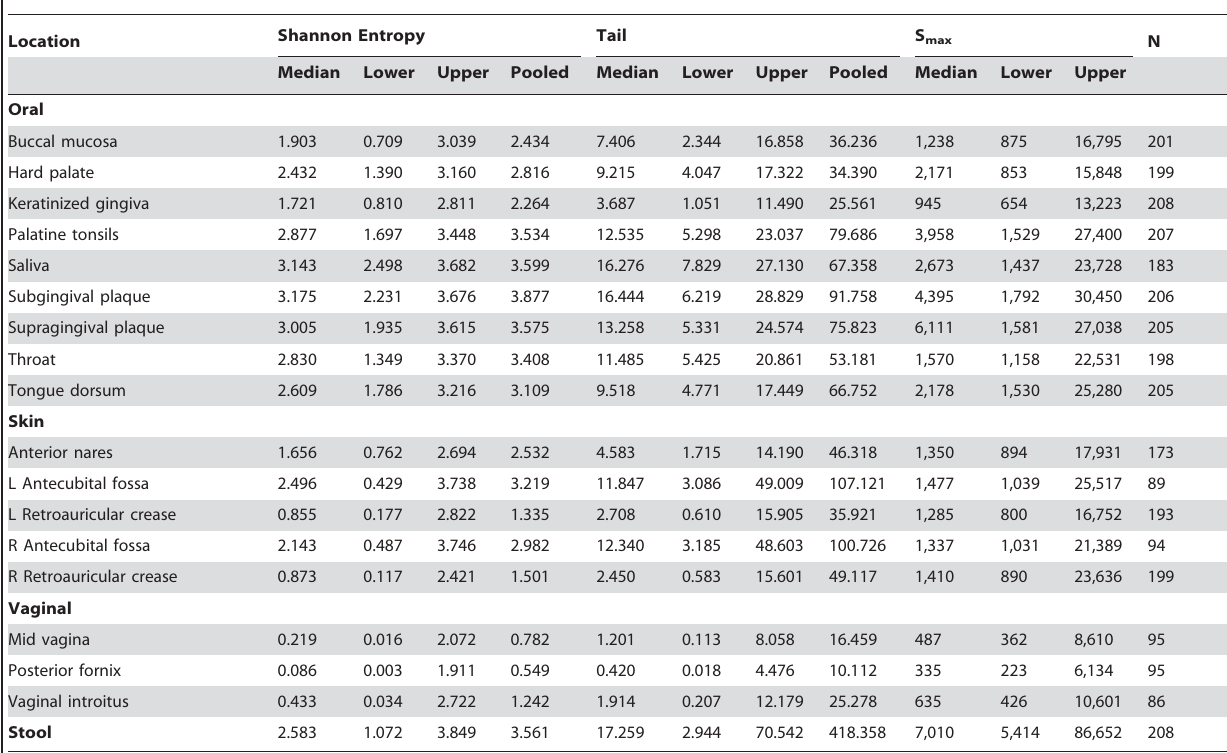
Table 2. Diversity indices computed on all OTU-based taxonomic